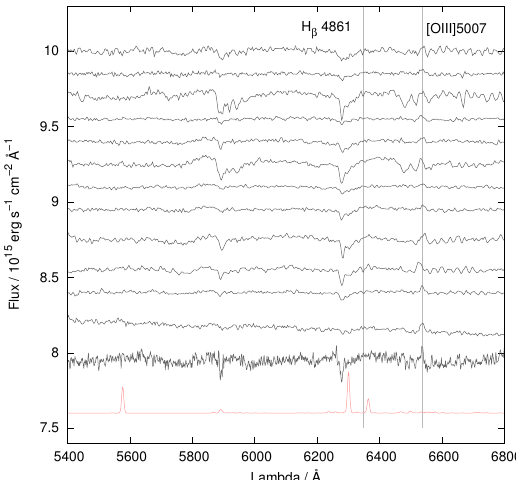
Figure 13. Optical spectra of OJ 287 taken at the Nordic Optical Telescope . The continuum has been fitted with a low-order polynomial and subtracted and the spectra have been shifted in vertical direction for clarity. The positions of λ 4861 H β and λ 50006 [OIII] at the redshift of OJ 287 are indicated by vertical lines. The red curve below shows the positions of prominent atmospheric emission lines. Apparent deep absorption structures in the spectrum are telluric lines. The epochs are (from top to bottom): 12 February 2010, 23 October 2010, 18 November 2010, 4 January 2011, 17 January